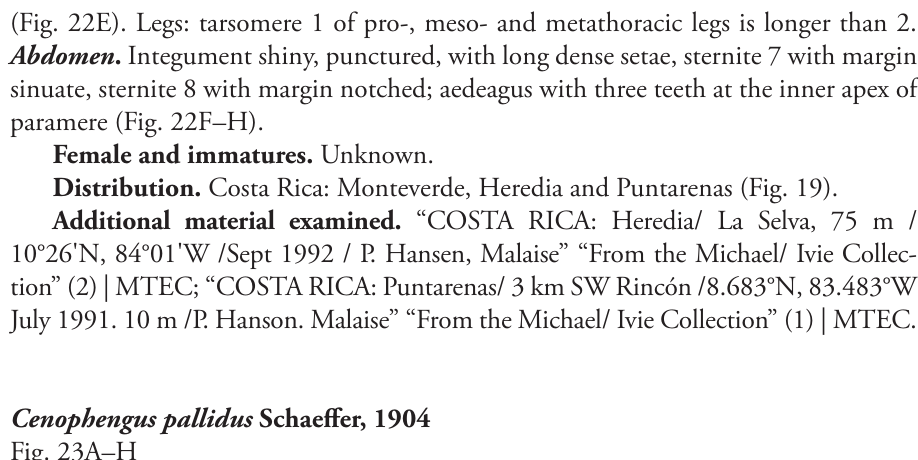
(Fig. 22E). Legs: tarsomere 1 of pro-, meso- and metathoracic legs is longer than 2. Abdomen . Integument shiny, punctured, with long dense setae, sternite 7 with margin sinuate, sternite 8 with margin notched; aedeagus with three teeth at the inner apex of paramere (Fig.